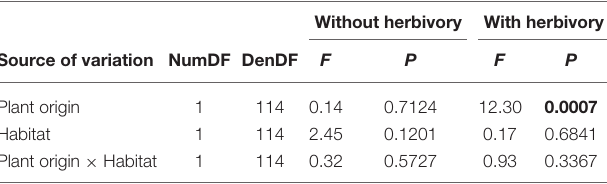
TABLE 2 | Results of linear mixed-effects models for PSFs separated by herbivory